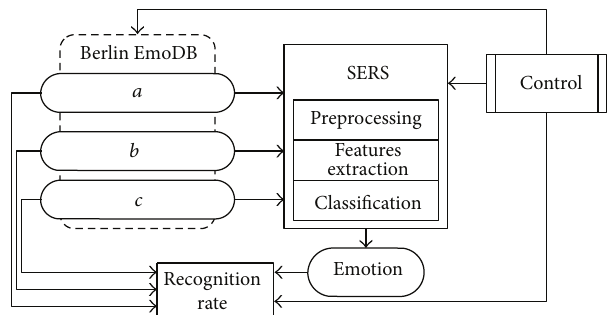
Figure 1: Block diagram of speech emotion recognition system (SERS). The system consists of a database that is used for training and testing and other blocks that describe functions of the algo- rithm. Different views on the issue are represented by blocks. ( 𝑎 ) Stress versus neutral state classification, ( 𝑏 ) each kind of emotion, and ( 𝑐 ) other approaches. Scenario option is represented by control block.